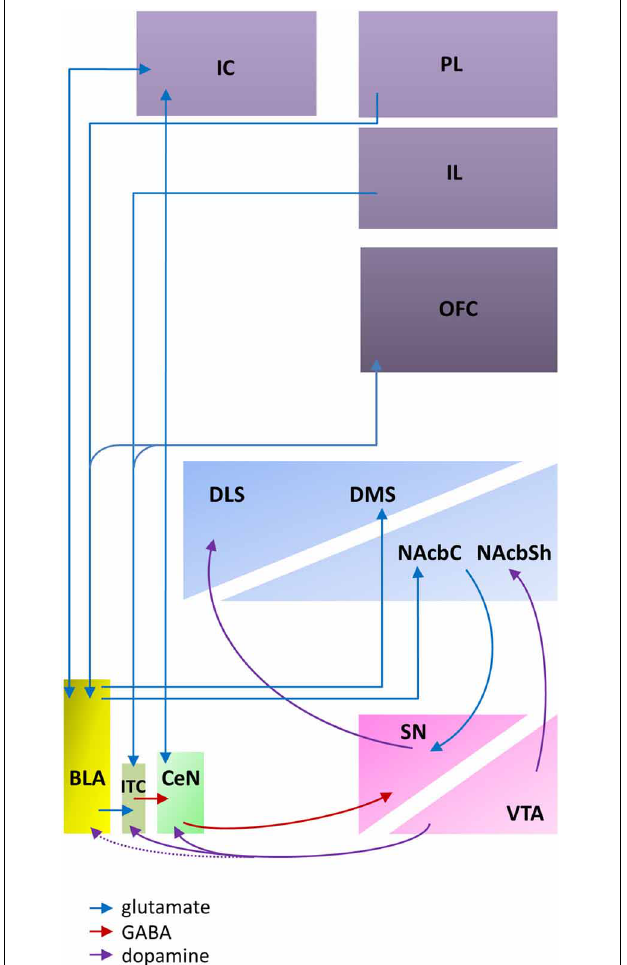
FIGURE 1 | An abbreviated diagram of amygdala connectivity with the cortex and striatum; refer to text for details on the functions of these connections. Abbreviations: BLA, basolateral amygdala; CeN, central nucleus of the amygdala; DLS, dorsolateral striatum; DMS, dorsomedial striatum; IC, insular cortex; IL, infralimbic cortex; ITC, intercalated cells; NAcbC, nucleus accumbens core; NAcbSh, nucleus accumbens shell; OFC, orbitofrontal cortex; PL, prelimbic cortex; SN, substantia nigra; VTA, ventral tegmental area. The dashed line indicates weak